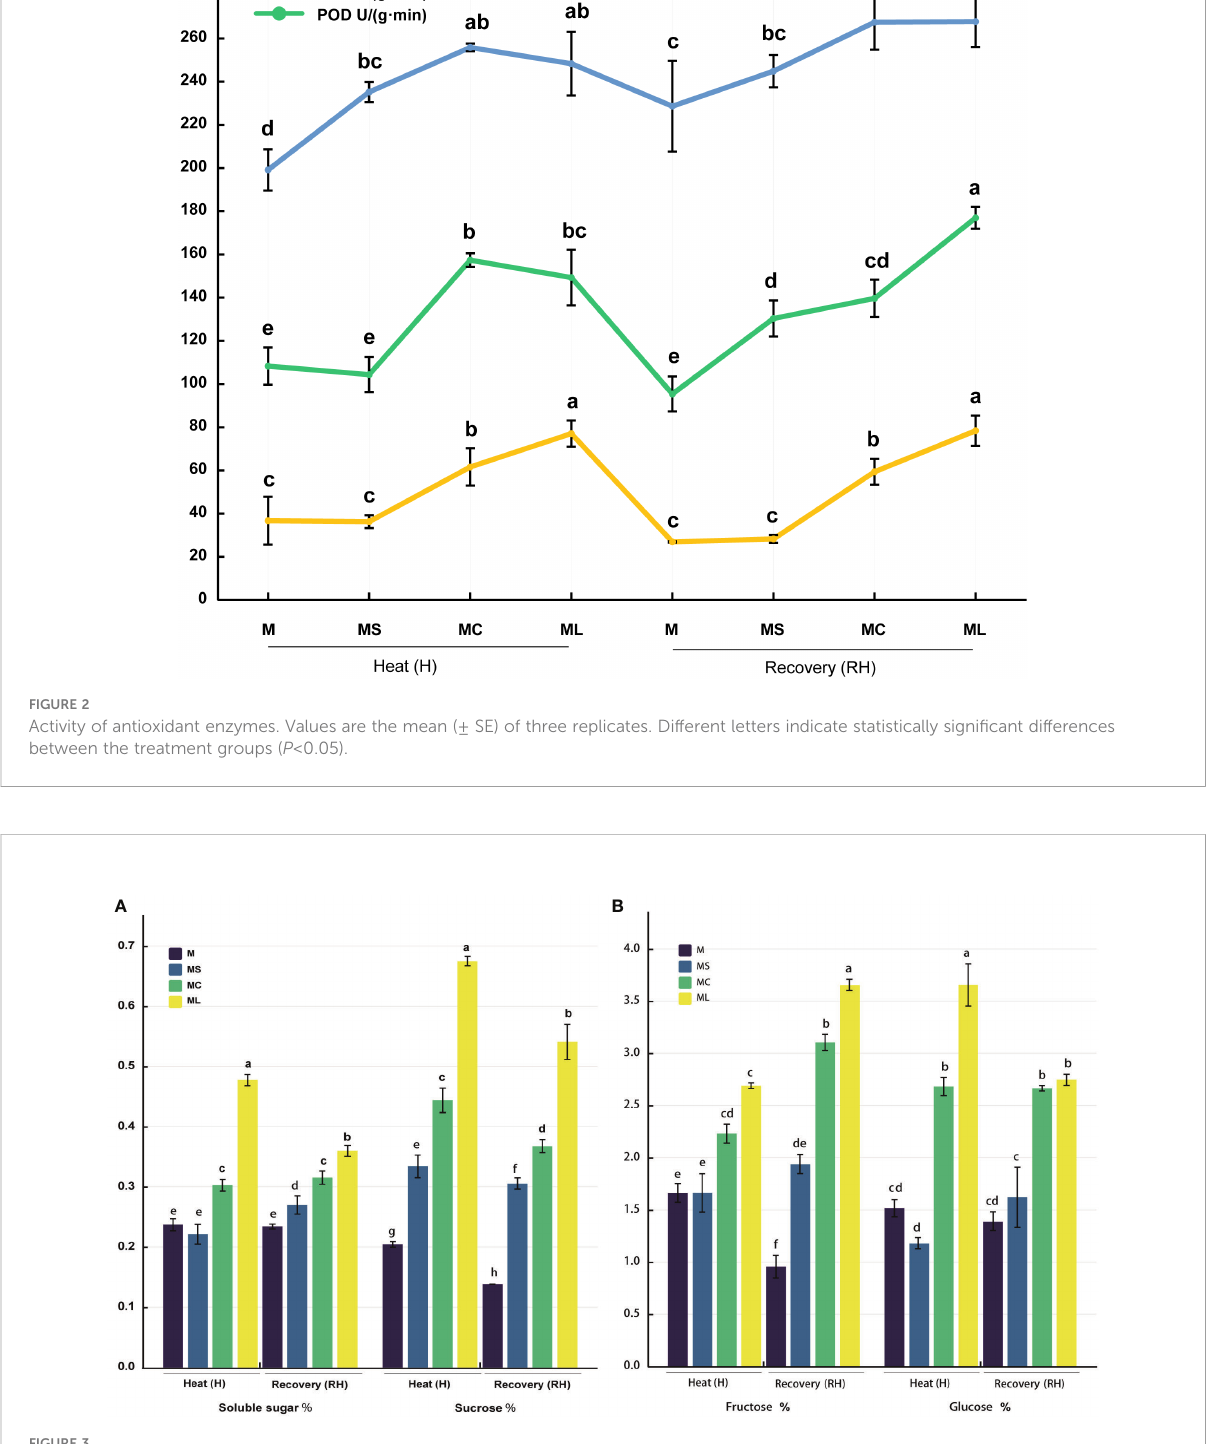
FIGURE 3 Carbon metabolite content. (A) Soluble sugar and sucrose content. (B) Fructose and glucose content. Values are the mean (± SE) of three replicates. Different letters indicate statistically signi fi cant differences between the treatment groups ( P< 0.05).